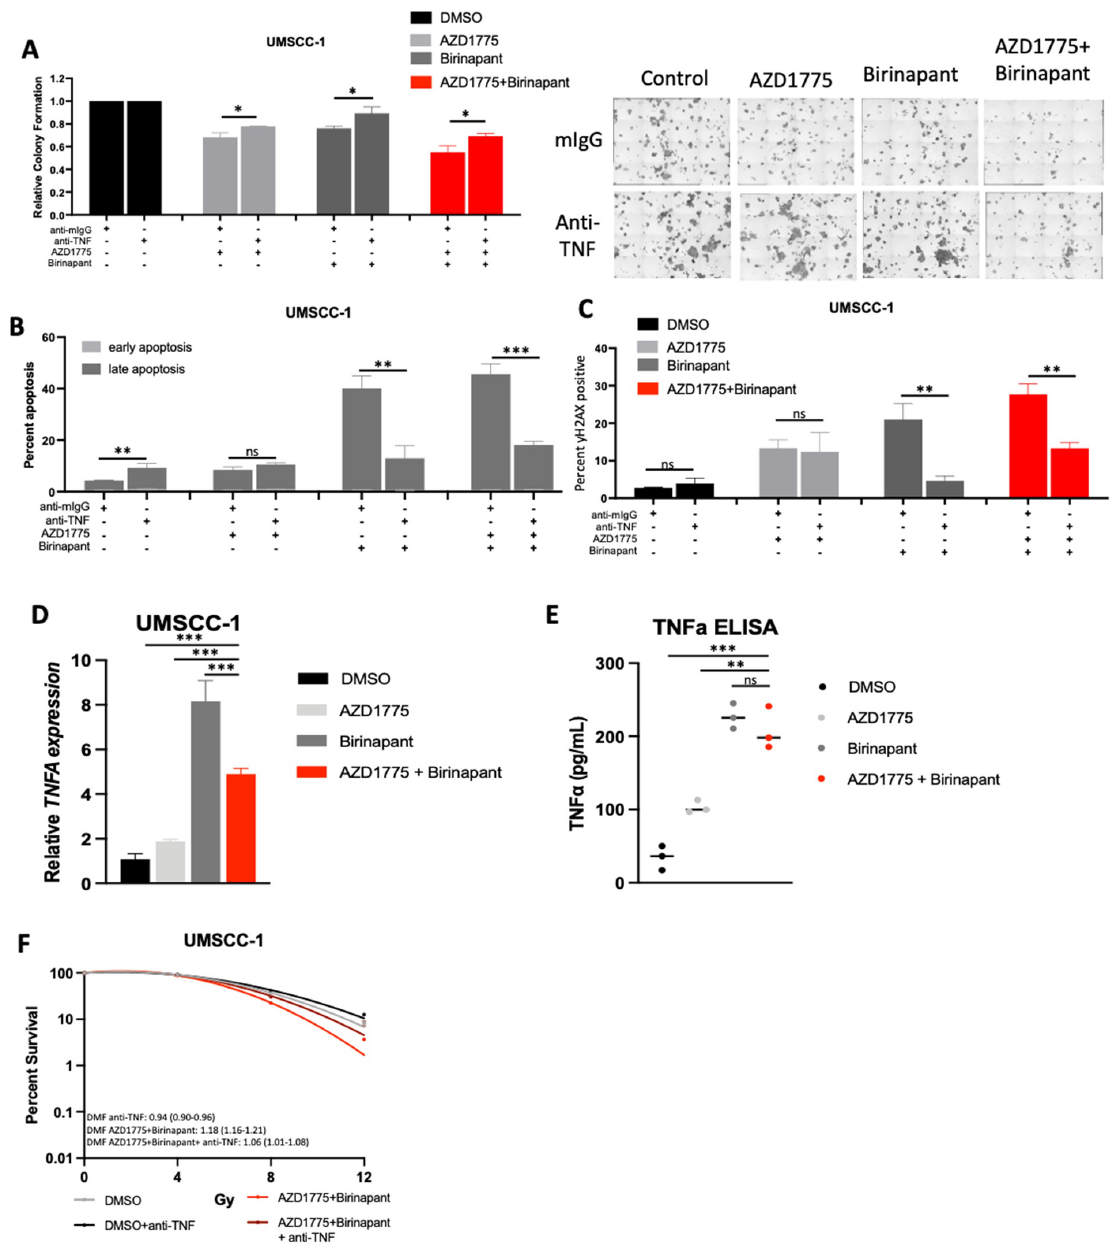
Figure 6. Combination treatment cytotoxicity in UMSCC-1 is at least partially TNF-driven. ( A ) Colony formation after 24 h of treatment with 500 nM AZD1775/Birinapant. Cells were pre-treated with control mouse IgG (1 µ g/mL) or anti-TNF (1 µ g/mL) for 4 h before treatment. n = 3. ( B ) Annexin apoptosis assay at 24 h with 500 nM AZD1775/Birinapant. Cells were pre-treated with control mouse IgG (1 µ g/mL) or anti-TNF (1 µ g/mL) for 4 h before treatment. n = 3. ( C ) Flow cytometry analysis of γ -H2AX positivity with 24 h of treatment with 500 nM AZD1775/Birinapant. Cells were pre-treated with control mouse IgG (1 µ g/mL) or anti-TNF (1 µ g/mL) for 4 h before treatment. n = 3. ( D ) qPCR analysis of TNF following treatment with indicated drug for 24 h, AZD1775/Birinapant = 500 nM, n = 3. U6 was used as a loading control. ( E ) ELISA assay of TNF protein expression following treatment with indicated drug for 24 h, AZD1775/Birinapant = 500 nM, n = 3. ( F ) Clonogenic survival assay with DMF score following 24 h treatment with AZD1775/Birinapant at 500 nM compared to DMSO control +/ − anti-TNF (1 µ g/mL). Single-dose ionizing radiation was administered 1 h following AZD1775/Birinapant pretreatment in UMSCC-1 (XRT= 0, 4, 8, 12 Gy) and UMSCC-47 (XRT = 0, 2, 4, 6 Gy). ns = not significant; * p < 0.05; ** p < 0.01; *** p <